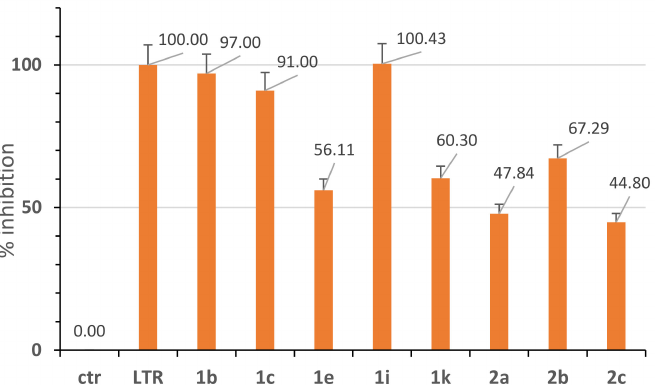
Figure 4. Aromatase inhibition results for new RSV derivatives. Letrozole, 1a – k and 2a – k were tested at 1 µ M. Measurements are referred to the means ± standard deviations (S.D.) of three